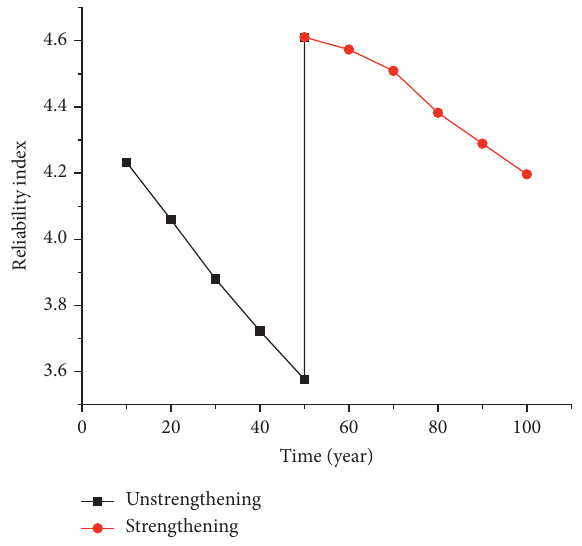
Figure 3: The time-dependent reliability index. Table 5: The beam time-dependent failure probability.